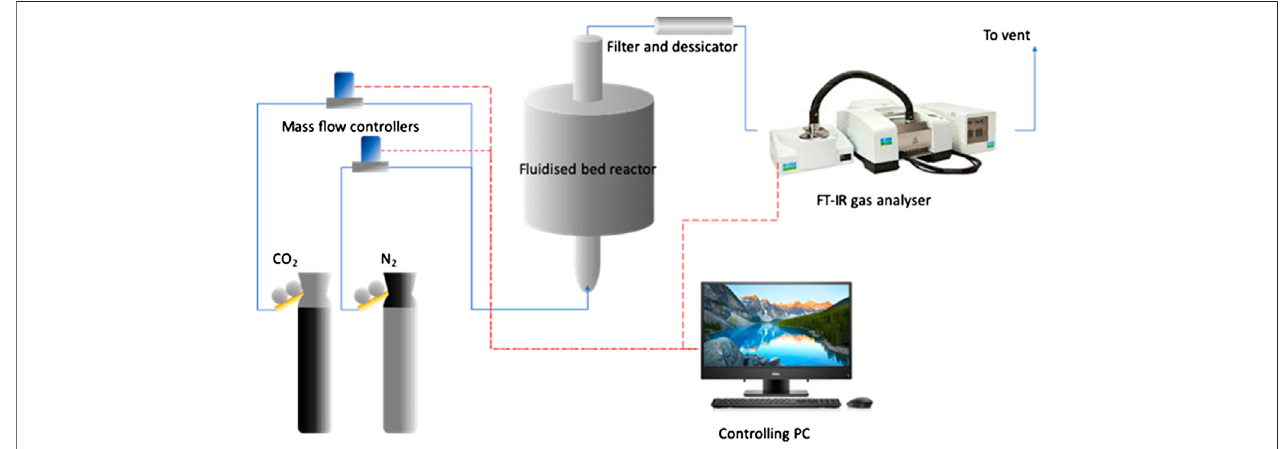
FIGURE 3 | Schematic diagram of the fl uidized bed reactor system. The blue solid lines represent gas lines; the red dashed lines represent electronic signal lines.